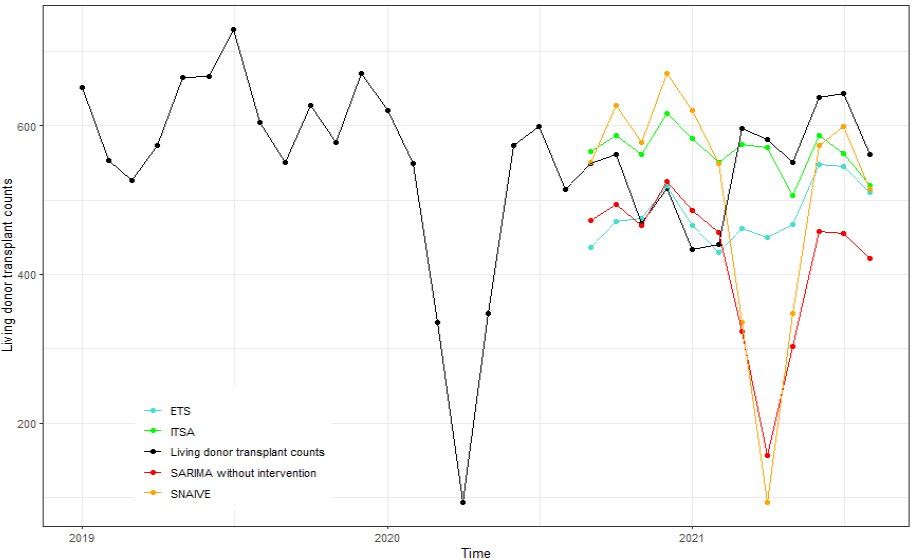
Figure 3. Forecasts of living donor transplant counts from September 2020 to August 2021 using ITSA, SARIMA without intervention, ETS, and